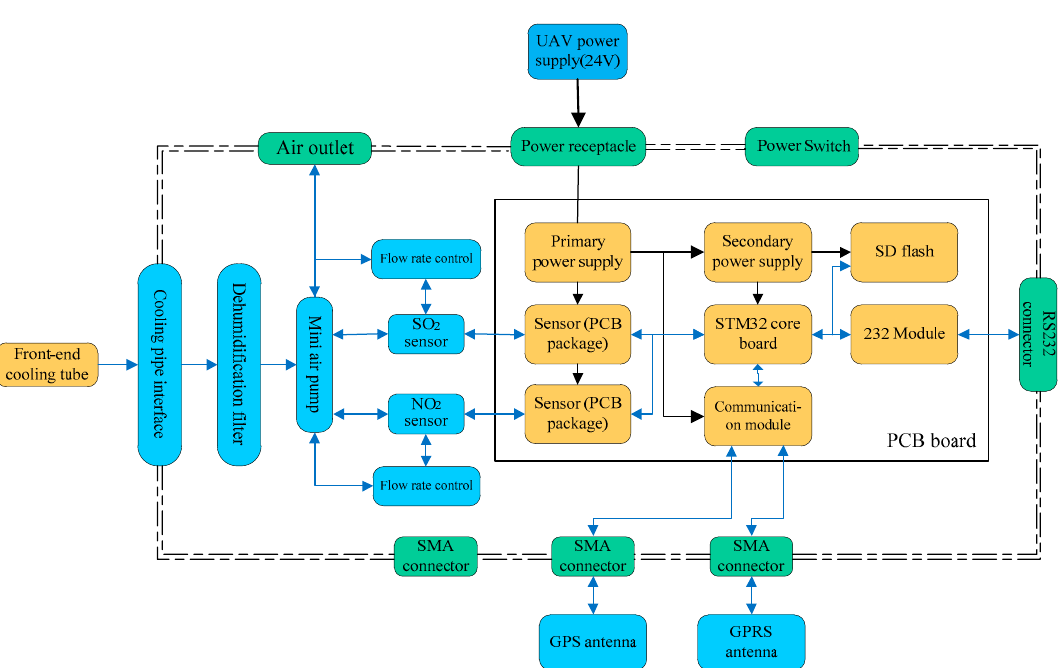
Figure 3. Structure of the pod. GPRS, general packet radio service; GPS, global positioning system; PCB, printed circuit board; STM32, a type of processor; SMA, small A type; SD, secure digital.